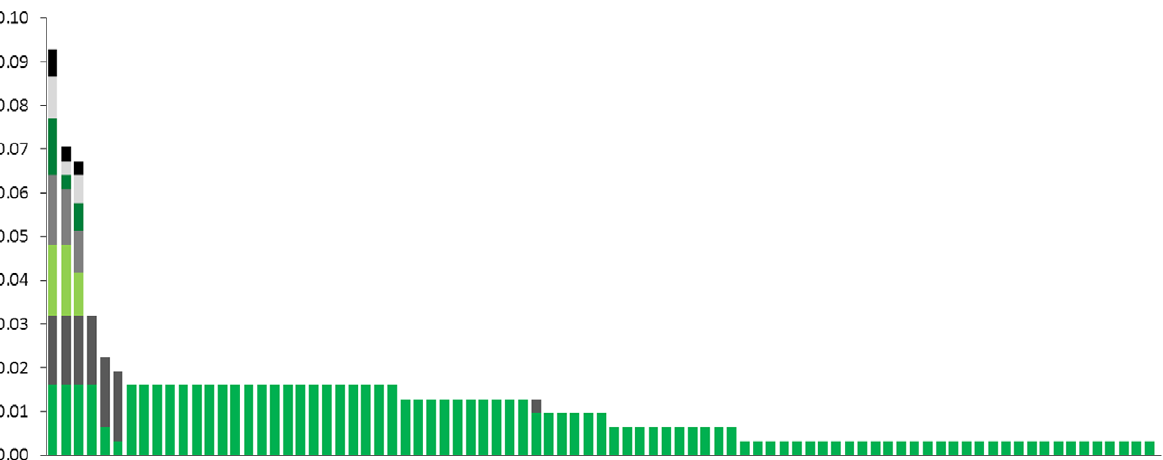
Figure 4. Distribution of the 85 mutilocus genotypes (MLG) found in the whole metapopulation. Each bar represents one MLG, ordered by their frequencies. For each bar the different colours indicate in how many patches the MLG was found.